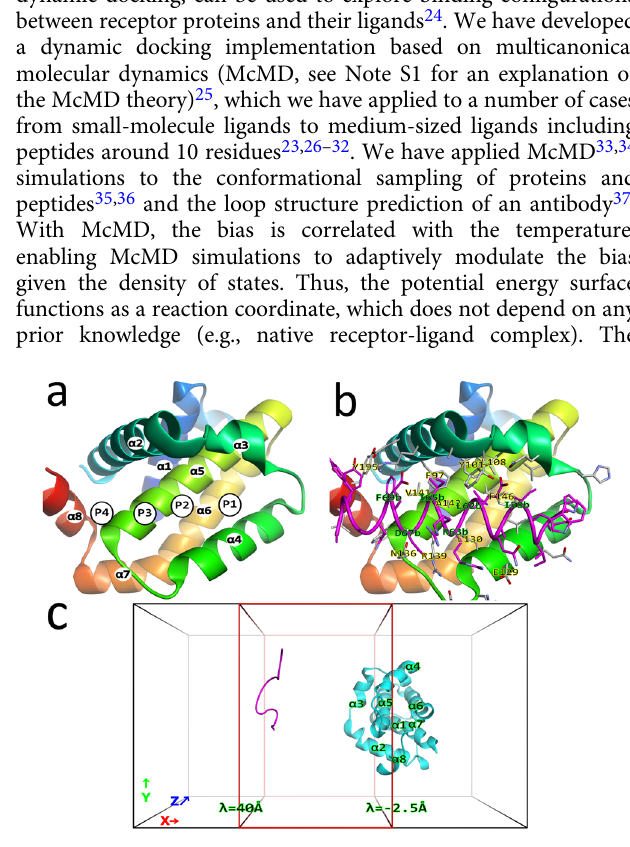
Fig. 1 Structural overview of Bcl-xL and Bim with the computational system. a Structure of Bcl-xL and location of the binding sites P1-P4, with the secondary structure elements α 1- α 8 labeled. b Complex structure of Bcl-xL (colored with a blue-red gradient from N- to C-terminal) and Bim (magenta), with contacting residues shown and labeled, with residues of Bim suf fi xed with a “ b ” . c One of the initial structures ( N = 30) of the computational system at the start of the simulations after the initial high- temperature simulations, with Bcl-xL in cyan and Bim with sequence CH 3 CO-IWIAQE LRRIGD EFNAYY-NH 2 in magenta (BH3-motif in bold). The center-of-mass (COM) of Bim is restrained to stay inside the red box along the x -axis. This is similar to the cylinder used in previous works with * the axis λ corresponding to the x -axis, and λ ranging from − 2.5 Å to 40.0 Å, where a force constant of 10 kcal/mol was used when the COM of Bim leaves this range along the axis, while no force was applied when the COM leaves the box perpendicular to the axis, thus periodic boundary crossings along the y - and z -axis were allowed. The images were produced using Molmil 64 , a WebGL based molecular viewer developed by PDBj 48 – 50